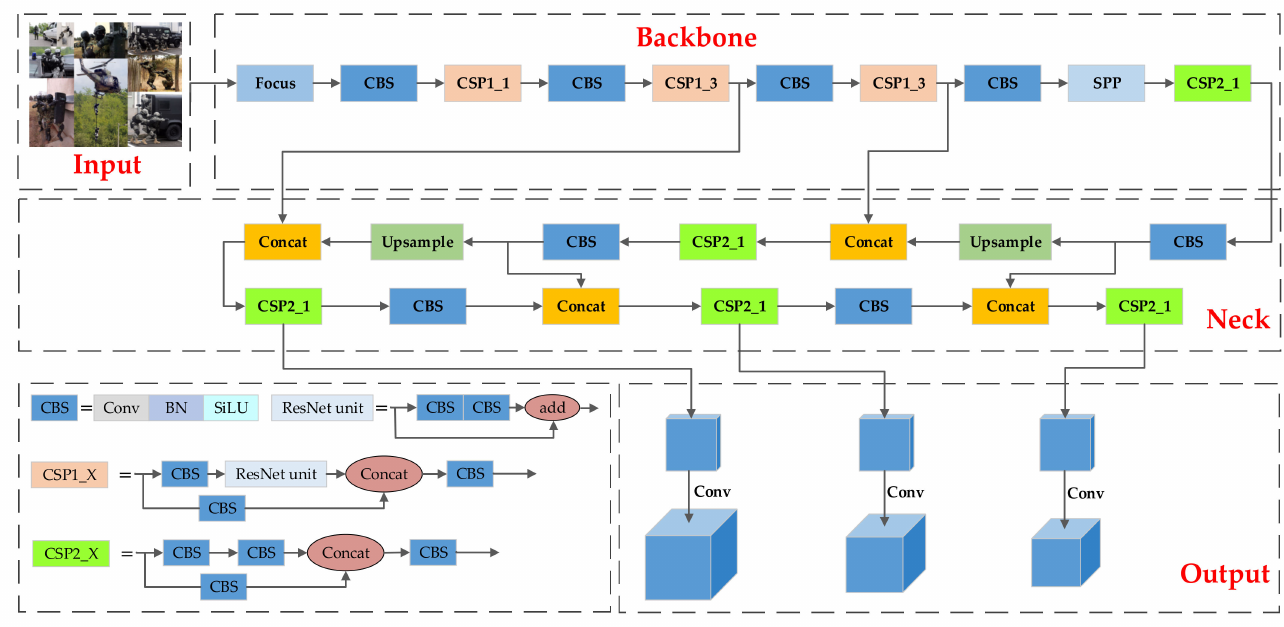
Figure 2. The structure of